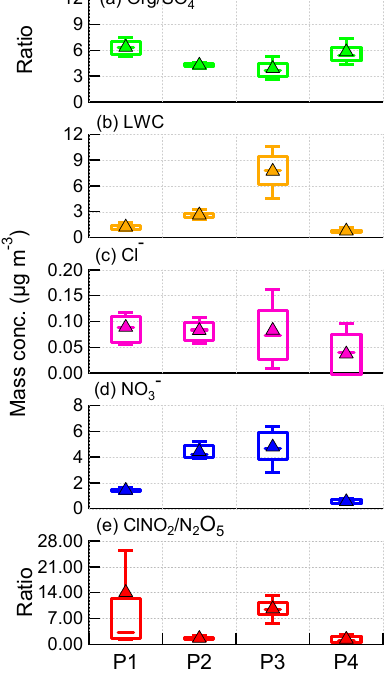
Figure 5. Box plots of (a) Org / SO 4 ratio, (b) LWC, (c) particulate chloride, (d) particulate nitrate, and (e) ClNO 2 / N 2 O 5 ratio for each night, i.e., P1, P2, P3, and P4. The mean (triangle), median (hori- zontal line), 25 and 75th percentiles (lower and upper box), and 10 and 90th percentiles (lower and upper whiskers) are